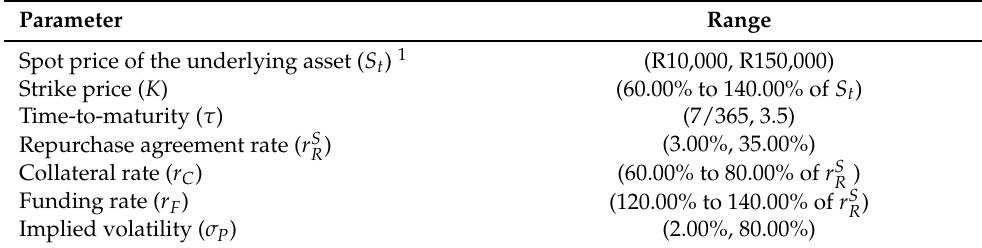
Table 1. Training set input parameter ranges.